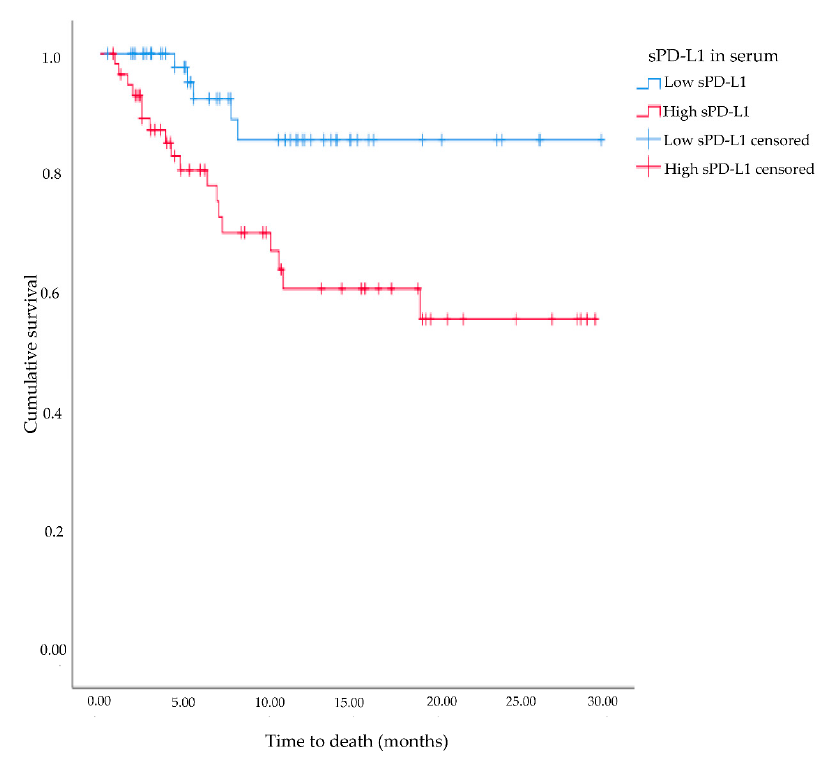
Figure 2. Kaplan-Meier survival plot for association of soluble programmed death ligand 1 (sPD-L1) levels (low vs. high) and overall survival among patients diagnosed with urinary bladder cancer between 2016 and 2019 within the BLAdder cancer Blood and Urine Study (BLABUS).